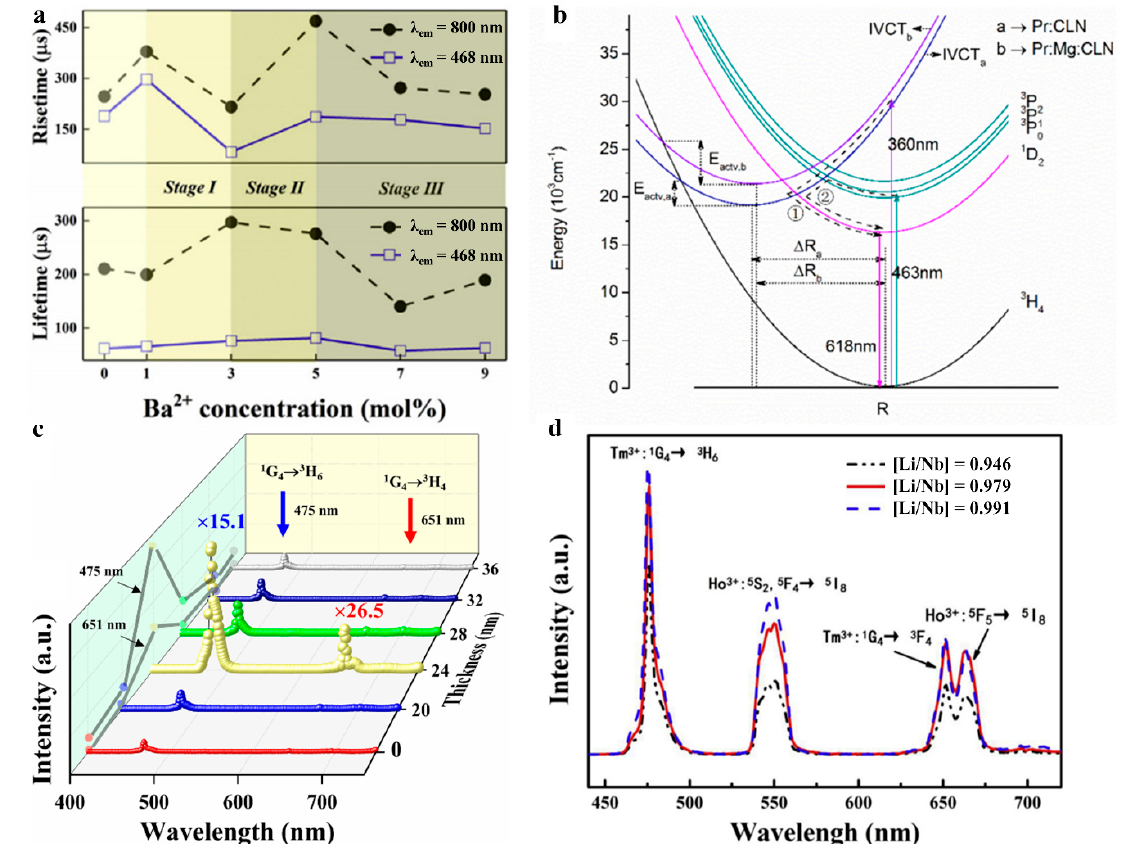
Figure 4. ( a ) The dependence of lifetime and rise time upon Ba 2+ concentration with 468 and 800 nm [41]; ( b ) The configurational coordinate diagram of Pr 3+ :CLN and Pr 3+ /Mg 2+ :CLN, depicting the light emitting mechanism based on the intervalence charge transfer [42]; ( c ) The UC spectra of Au-coated Tm 3+ /Yb 3+ /LN wafers in different film thickness [43]; ( d ) Upconversion emission spectra of Ho 3+ /Yb 3+ /Tm 3+ :LiNbO 3 single crystals with different [Li]/[Nb] ratios ([Li]/[Nb] = 0.946, 0.979 and 0.991) under 980 nm excitation at room temperature [44].